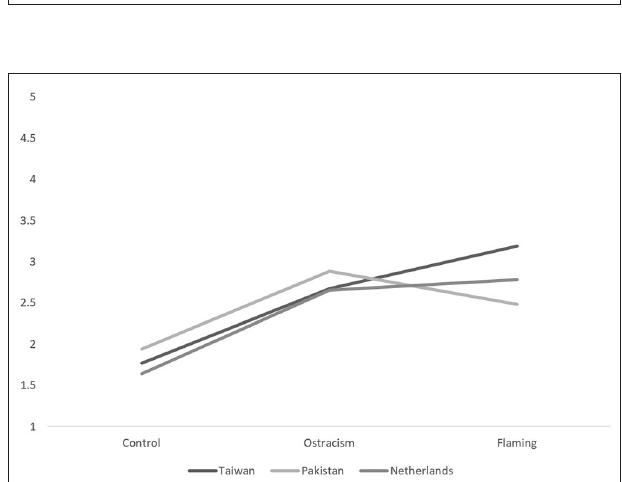
FIGURE 4 | The between-subjects interaction between nationality and trolling type for withdrawal